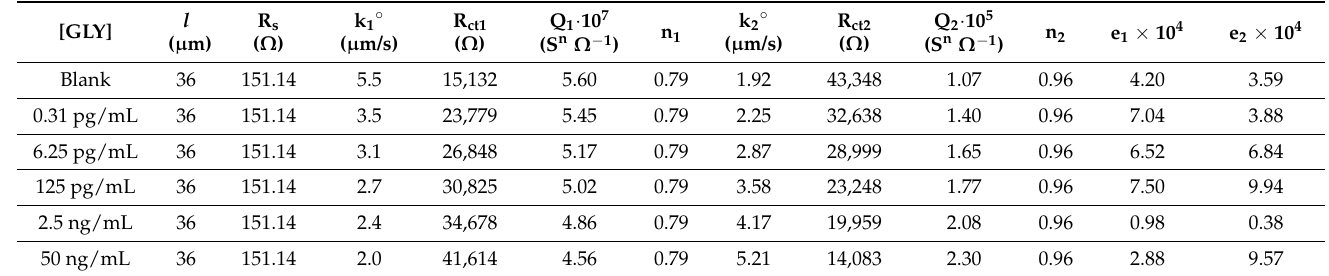
Table 2. Different parameters of CS-MIPs/CMA/Au estimated by the model for different concentra- tions of